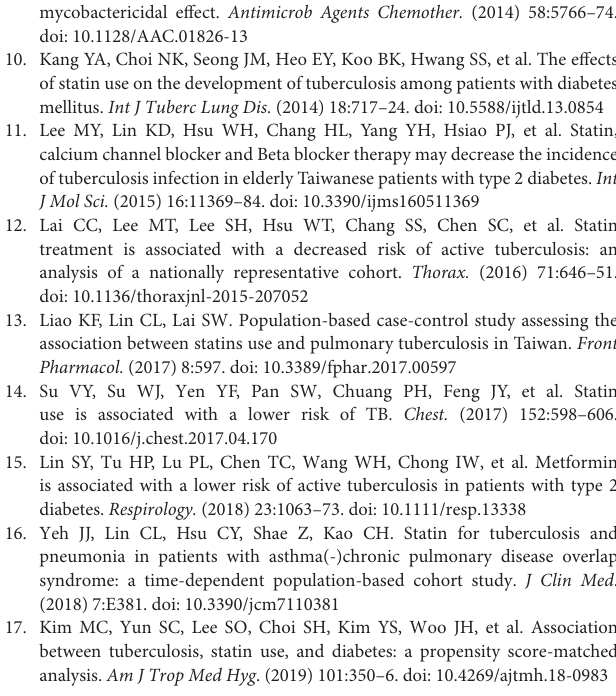
tuberculosis infection should be analyzed in future